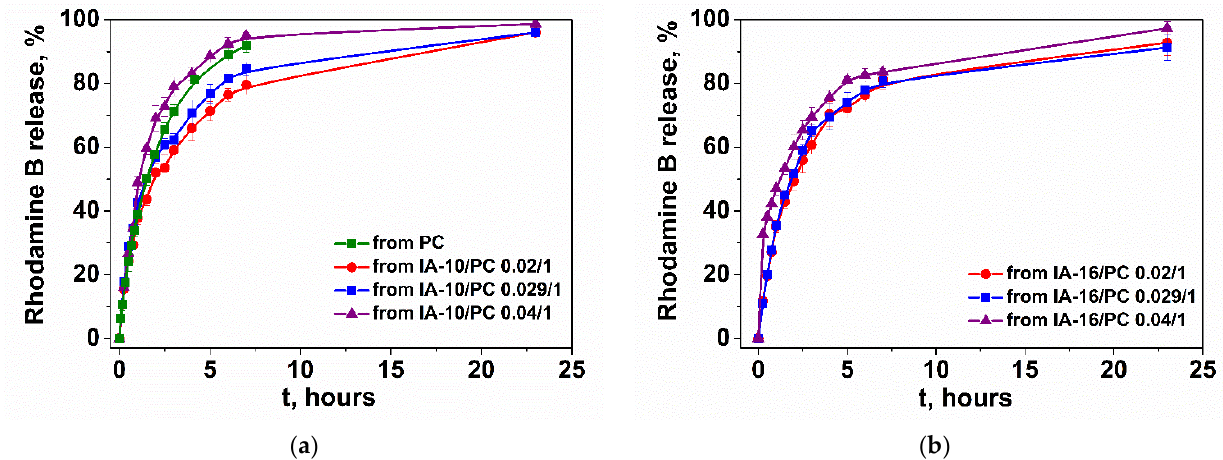
Figure 3. In vitro rhodamine B release from mixed liposomes at various surfactant/lipid molar ratios: ( a ) IA-10/PC; ( b ) IA-16/PC; phosphate buffer (0.025 M), pH 7.4, 37 °C.